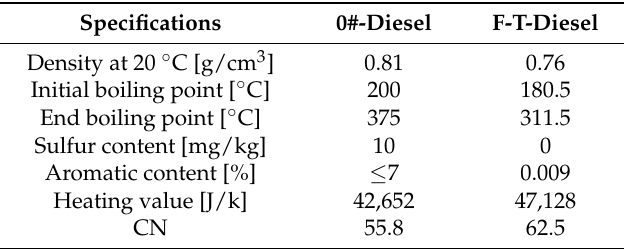
Table 3. The main specifications of the